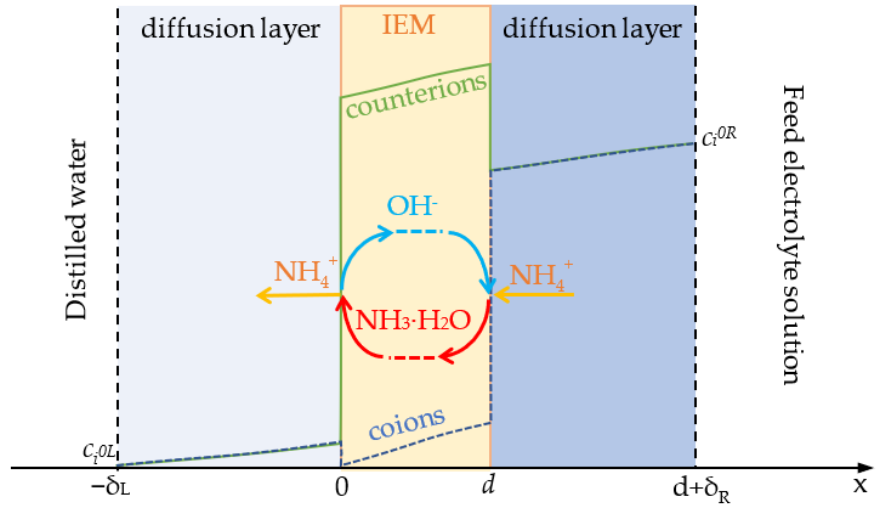
Figure 4. Schematic representation of the system under study. Here, δ L , δ R and d are the diffusion boundary layer ( L —left hand and R —right hand) and membrane thicknesses, respectively.